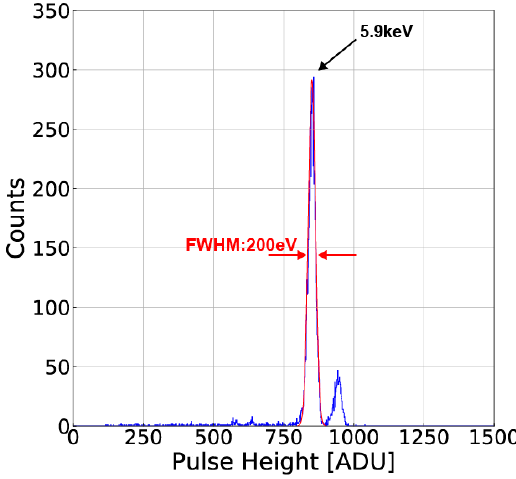
Figure 20. Measured X-ray spectra of 55 Fe as single-pixel events using the SOIPIX-PDD.